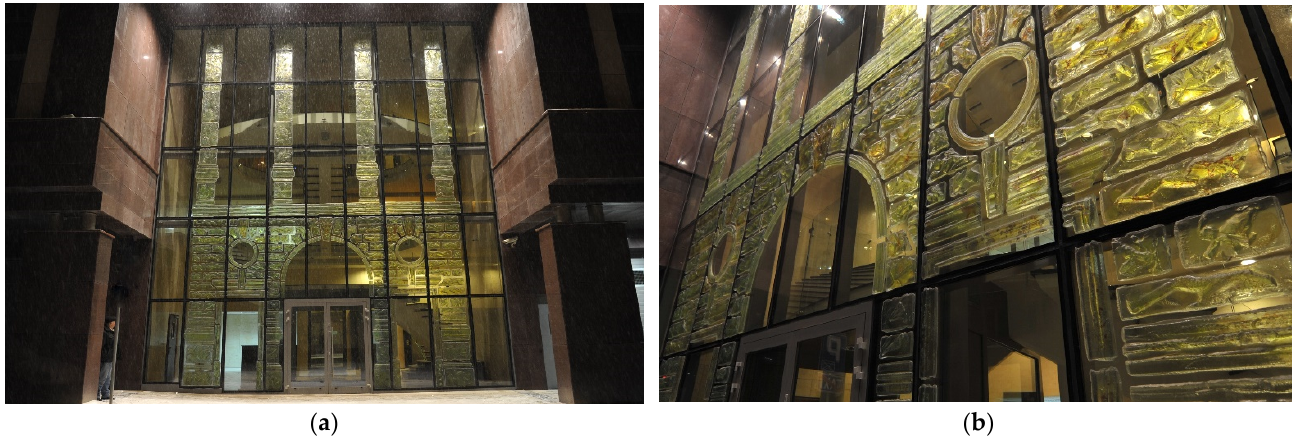
Figure 11. Glass façade by Tomasz Urbanowicz in the Just In Center at Krawiecka Street in Wrocław, Poland, 2009: ( a ) the laminated casted-glass elements in a layout reminiscent of the destroyed building of the Imperial Main Post Office; ( b ) detail of the façade’s kiln-formed glass casts introducing the texture and color of the original stone rustication (Tomasz